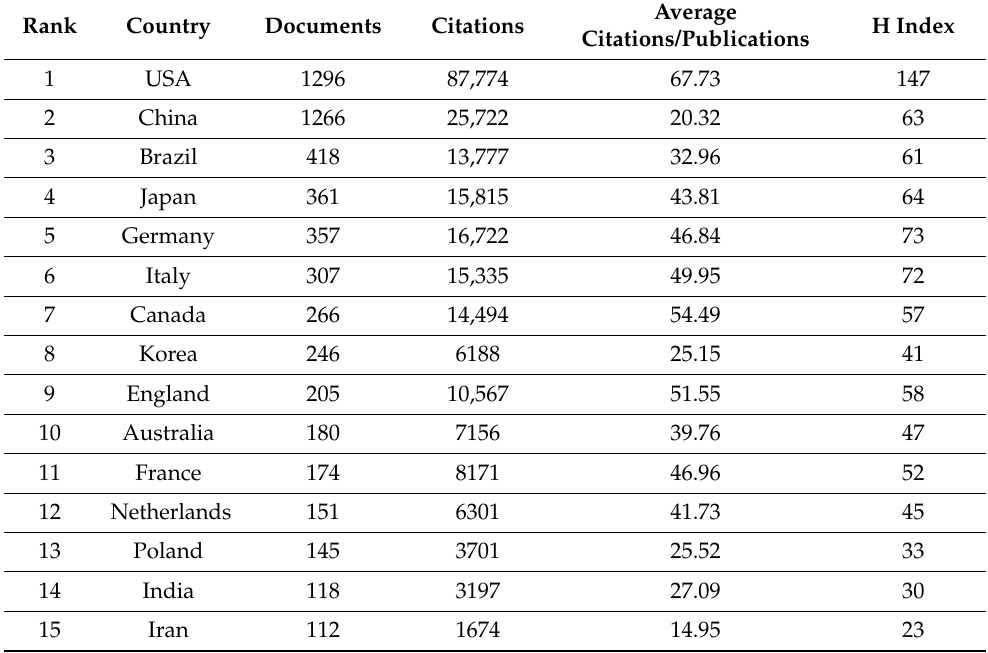
Table 2. Contributions of countries or regions. The top 15 countries for the association between depression and BDNF